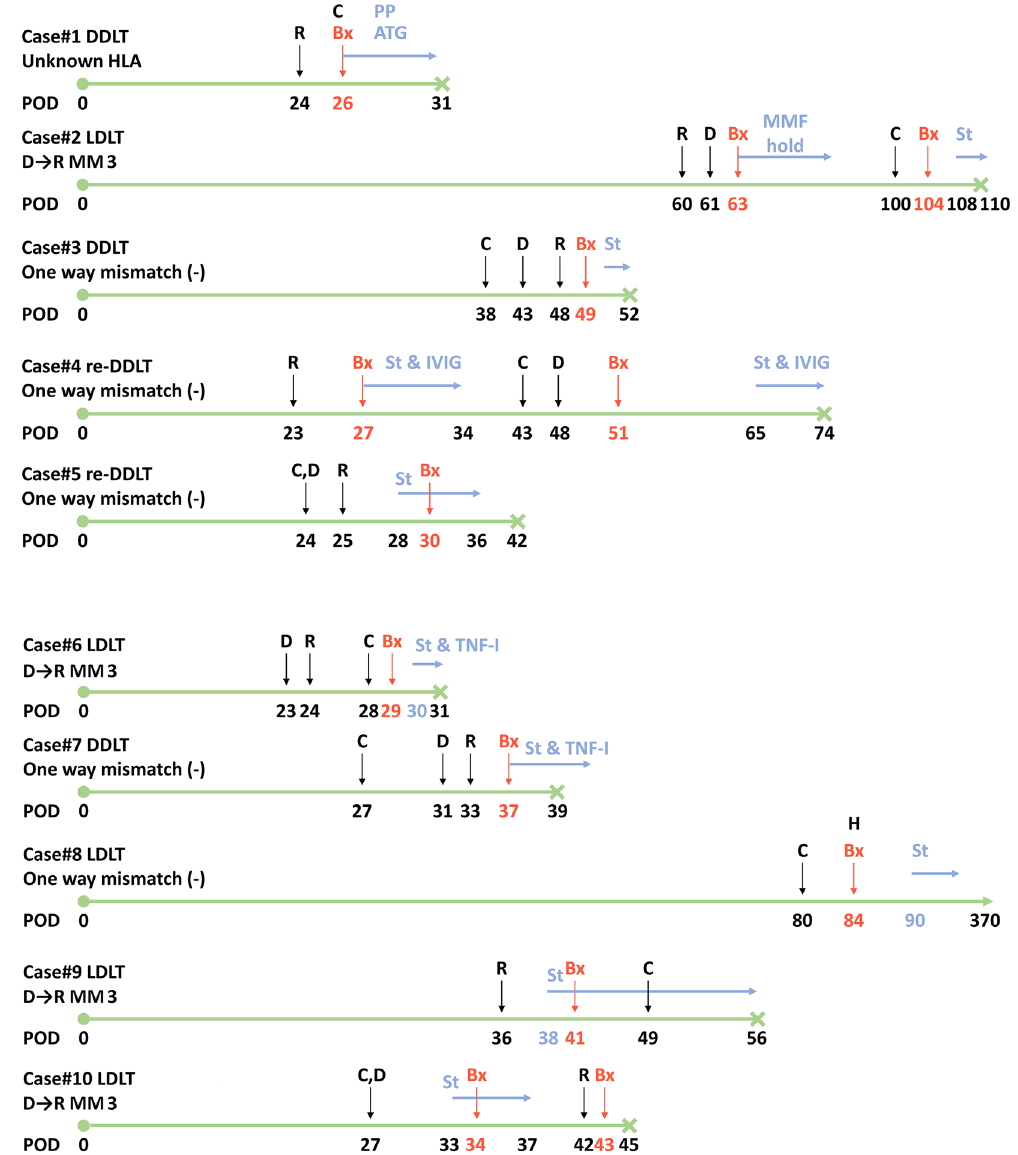
Figure 3. Timelines of patients with